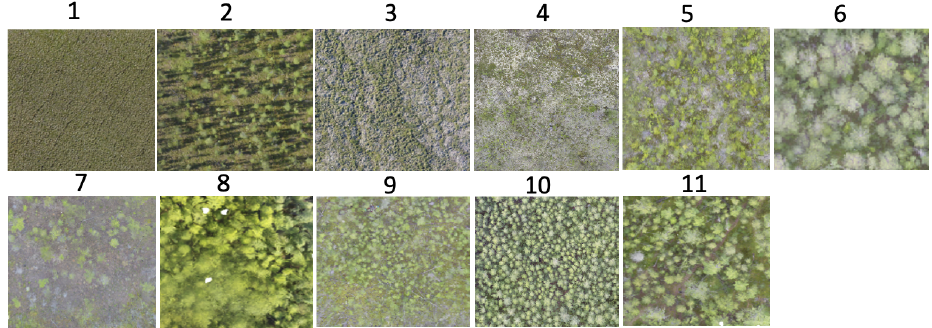
Figure 20. Visual representation of the 11 vegetation classes from the orthomosaics (see also Appendix Table A1). The varying quality of the orthomosaics is described in Sect.